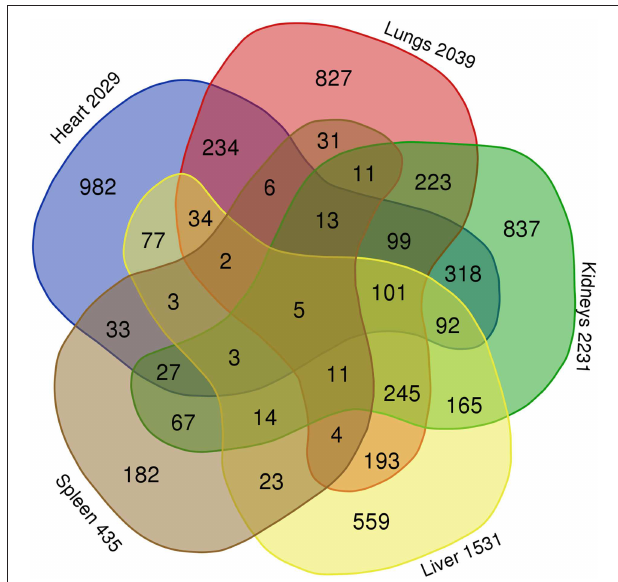
FIGURE 3 | Comparison of differentially expressed gene transcripts in FFPE tissue samples (lungs, heart, kidneys, liver, and spleen) from meningococcal septic shock patients vs. control patients (acute non-infectious death). Gene transcripts with signal values of < 5 (log2) across all arrays were removed to filter for low and non-expressed genes. For expression comparisons of different groups, the profiles were compared using a one way ANOVA model. P -value < 0.05, correction FDR 5%. The Venn diagram illustrate that 827 gene transcripts were specific for the lungs of the 2039 differentially expressed gene transcripts, in heart 982 of 2029, in kidneys 837 of 2231, in liver 559 of 1531 and in spleen 182 of 435. Five gene transcripts were common for lungs, heart, kidneys, liver, and